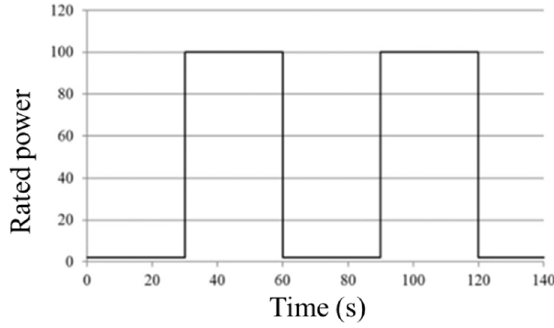
Figure 2. The Fuel Cell Technical Team (FCTT) duty cycle [119] (Reproduced with permission from Ira Bloom et al. [119], Journal of Power Sources; published by Elsevier B.V, 2013).